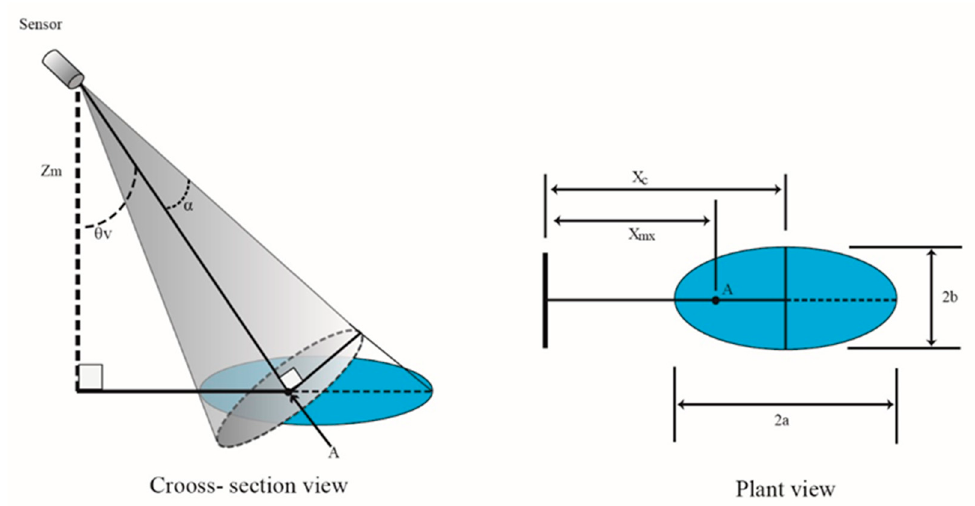
Figure 3. Footprint associated with the viewing geometry of the sensor where the footprint varies with view zenith angles [47].